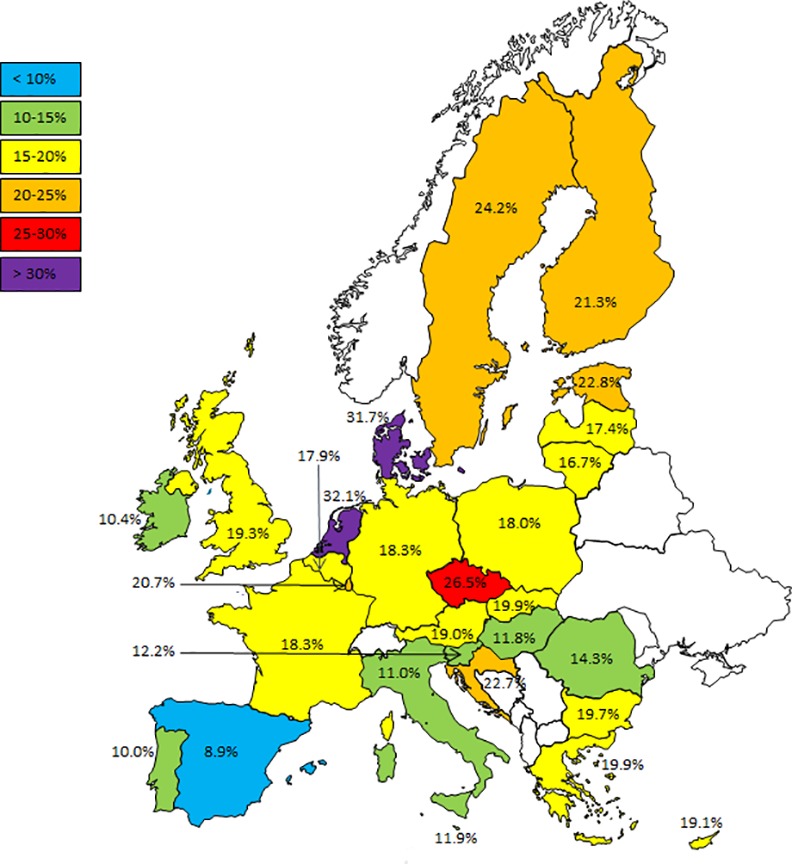
The distribution of the proportion of European adults reporting sitting more than 7.5 hours per day across the 28 European Union Member States.Designed by Showeet.com.